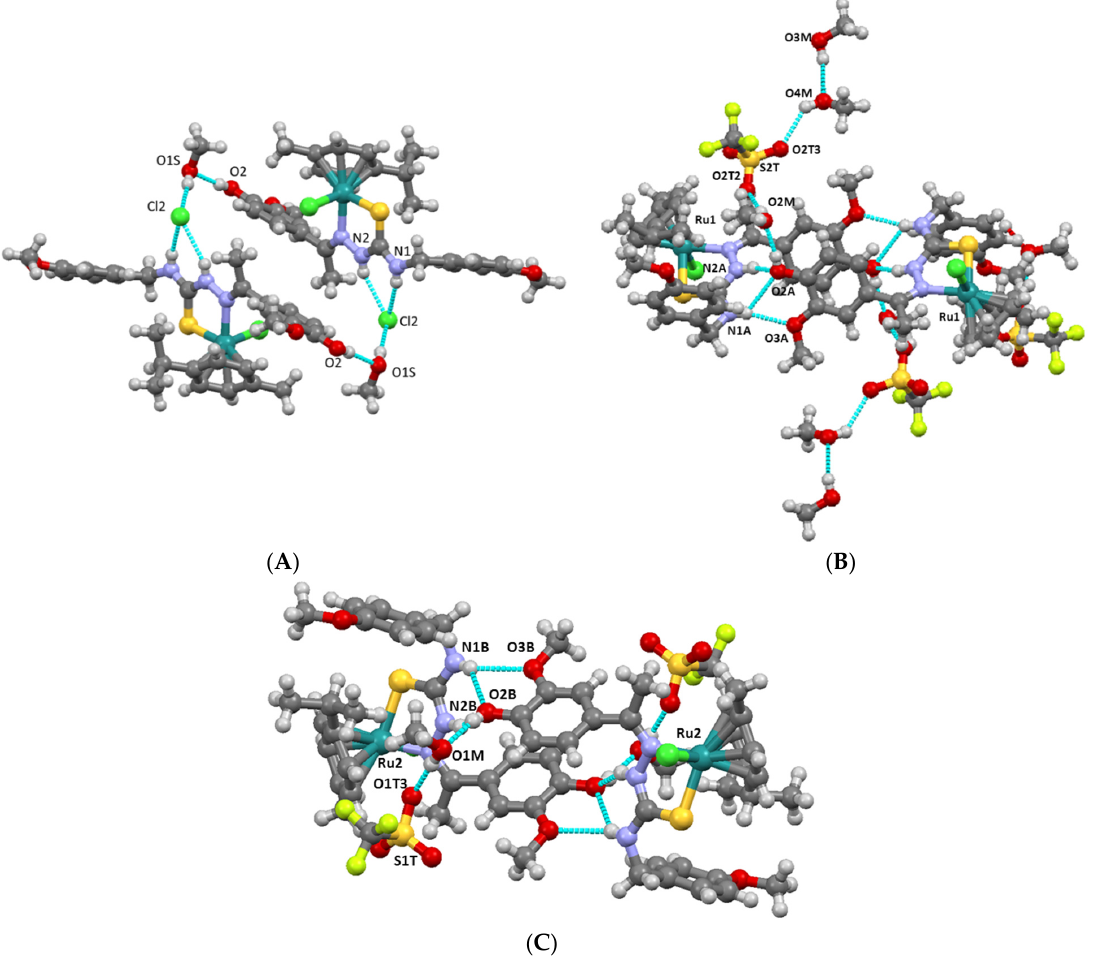
Figure 3. The intermolecular associations in 1(Cl) .CH 3 OH ( A ) and 1(TfO) .2(CH 3 OH) ( B , C ). In the structure of [Ru 2 ( μ -L 2 ) 2 ( η 6 - p -cymene) 2 ][O 3 SCF 3 ] 2 , 2’(TfO) , the thiosemicarba- zone ligand undergoes deprotonation and the sulfur atom acts as a bridge, displacing the chloride ligand from coordination to ruthenium (Figure 4A). The resulting thiosemi- carbazonate coordination mode μ - κ 2 S,N3: κ S, which has been previously observed in other d 6 systems such as ruthenium(II) [17,19] and rhenium(I) [32], gives rise to dimeric structures based on the formation of Ru 2 S 2 diamonds. Note that, as observed in the rhe- nium complexes, dimers based on M 2 S 2 can be formed with the thiosemicarbazonate ligand through the formation of a four-membered chelate ring by coordination of nitro- gen N2 and the sulfur [12]. Although several arrangements are possible, in the present case the mass center of the dimer lies on an inversion center, which means that the dimer consists of two identical units. The Ru1–S1 #1 bridging bond (2.4085(9) Å) is substantially longer than the bond that forms the chelate ring (2.3617(10) Å). The conformation of the thiosemicarbazonate chain (C2–N3–N2–C1(S)–N1) is Z , E , Z , E , where the substituents on the C2 and N1 atoms seem to avoid the coordination core. The Ru–S1 distance is intermediate between those observed in 1(Cl) and 1(TfO), while the Ru1–N3 distance is clearly the shortest of all the ruthenium complexes included in this study. When compared to the free and non-deprotonated HL 2 ligand structure, the S1–C1 distance seems to be much longer, while N2–C1 is much shorter. The same conclusion can